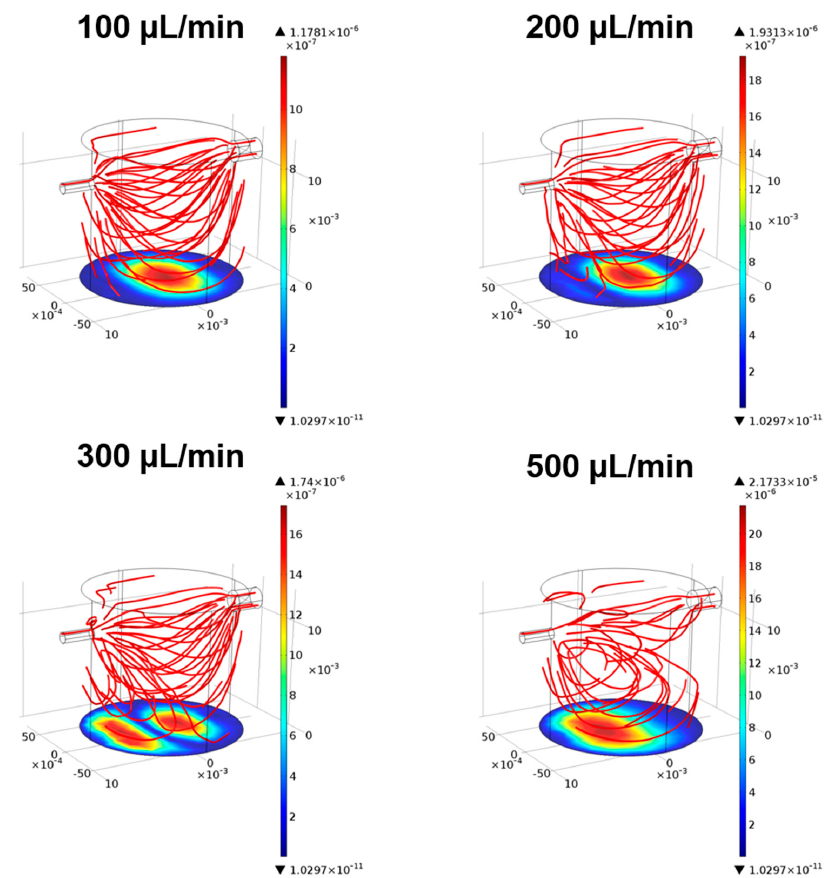
Figure 4. Results from the CFD models. Velocity streamlines (red) show how laminarity is compromised at higher flow rates. The surface plots at the bottom of the bioreactor show the fluid ‐ induced shear stress (Pa) with the scale bar indicating the maximum ( top ) and minimum values ( bottom ).